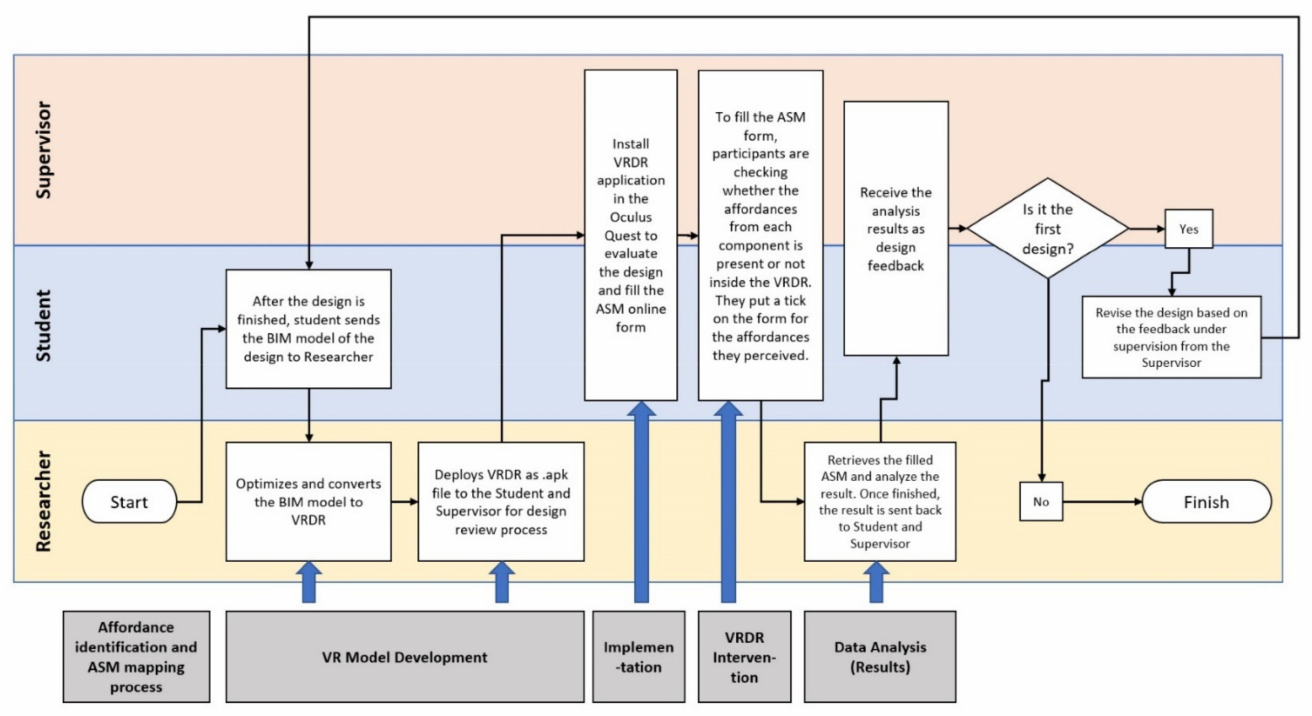
Figure 4. Workflow for Part 1